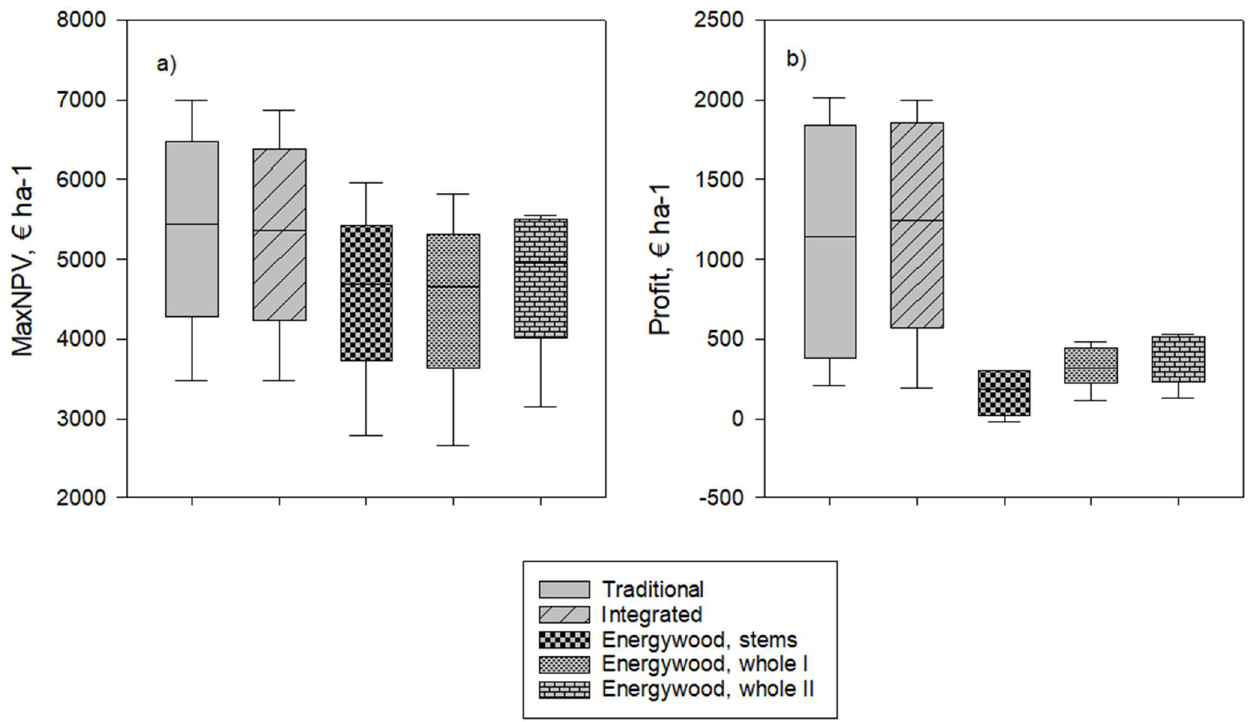
Figure 3. ( a ) Boxplots presenting the maximum NPV of options 1–5, € ha − 1 (private forest owner’s viewpoint), and ( b ) profit associated with options 1–5 at the first commercial thinning (contractor’s point of view). (Note that bottom edge of each box illustrates the 25th percentile, upper edge the 75th percentile, a line within a box marks the median and whiskers of the boxplots indicate 5th and 95th percentiles.)